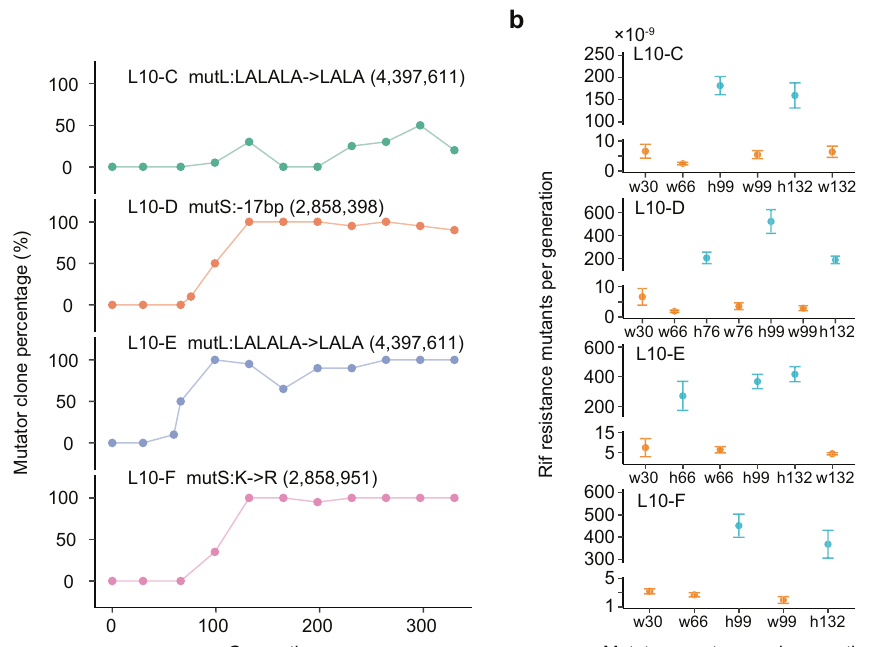
Fig. 3 | Temporal evolution of hypermutation in the L10 transfer scheme. a Frequency trajectories of candidate mutations in each population. b Mutation rates of clones with different mutator genotypes isolated at different evolutionary times were estimated by fl uctuation tests conferring rifampicin (Rif) resistance. n =3 independent colonies per genotype and generations. Data are presented as